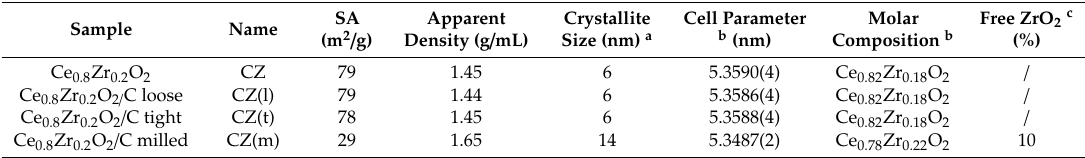
Table 1. Characteristics of the materials.